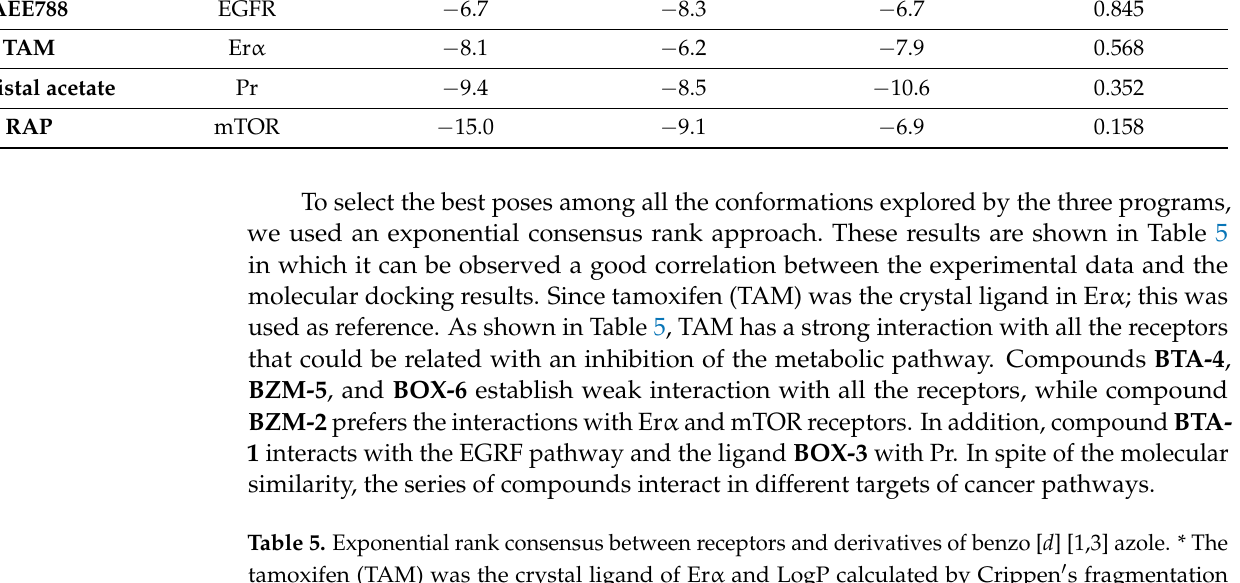
Table 4. Docking validation for the four receptors using three different molecular docking programs. The calculated root-mean-square deviation (RMSD) respect to the crystalized ligand is also shown. Compound